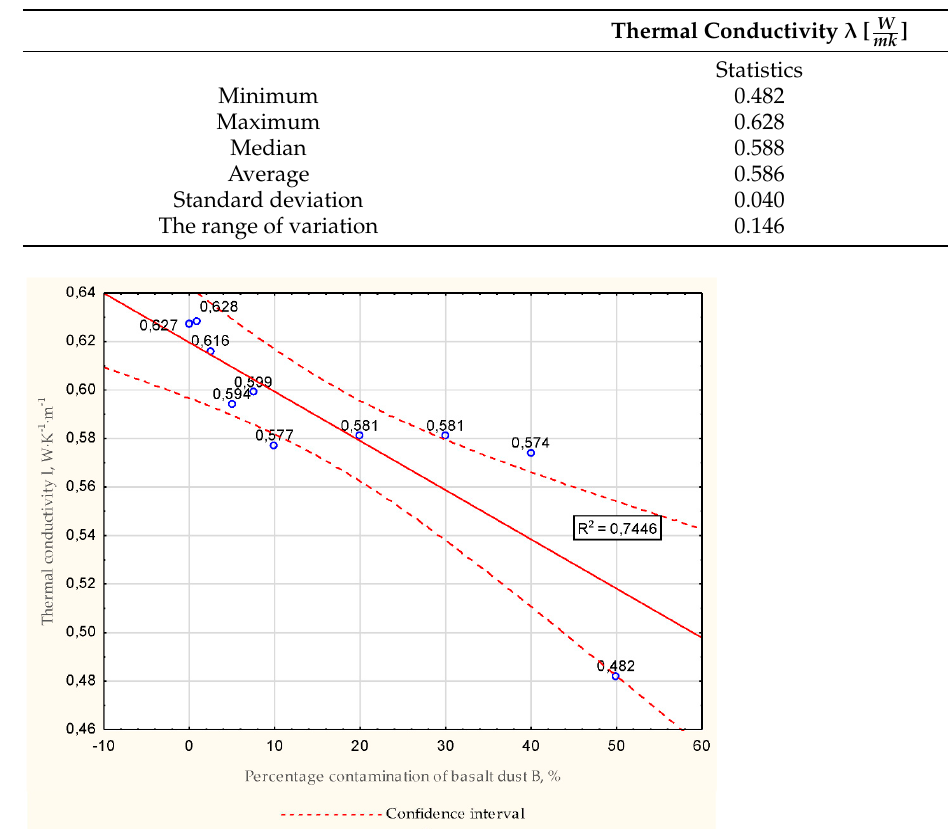
Figure 11. Average thermal conductivity for basalt dust A for water − mix ratio = 0.7. Analysis of the results for basalt dust A with a water mix–ratio = 0.7 shows a decreasing trend in the value of the thermal conductivity. This trend occurred as the concentration of basalt dust in the slurry increased. The lowest value of thermal conductivity was obtained for the sample containing 40% basalt dust in its composition. The value of the thermal conductivity coefficient in this case was lower than that of the zero sample by almost 20%. For the remaining samples, reduction varied by about 5% to 19%. Table 8. Average thermal conductivity for basalt dust B for all samples for water − mix ratio = 0.5.